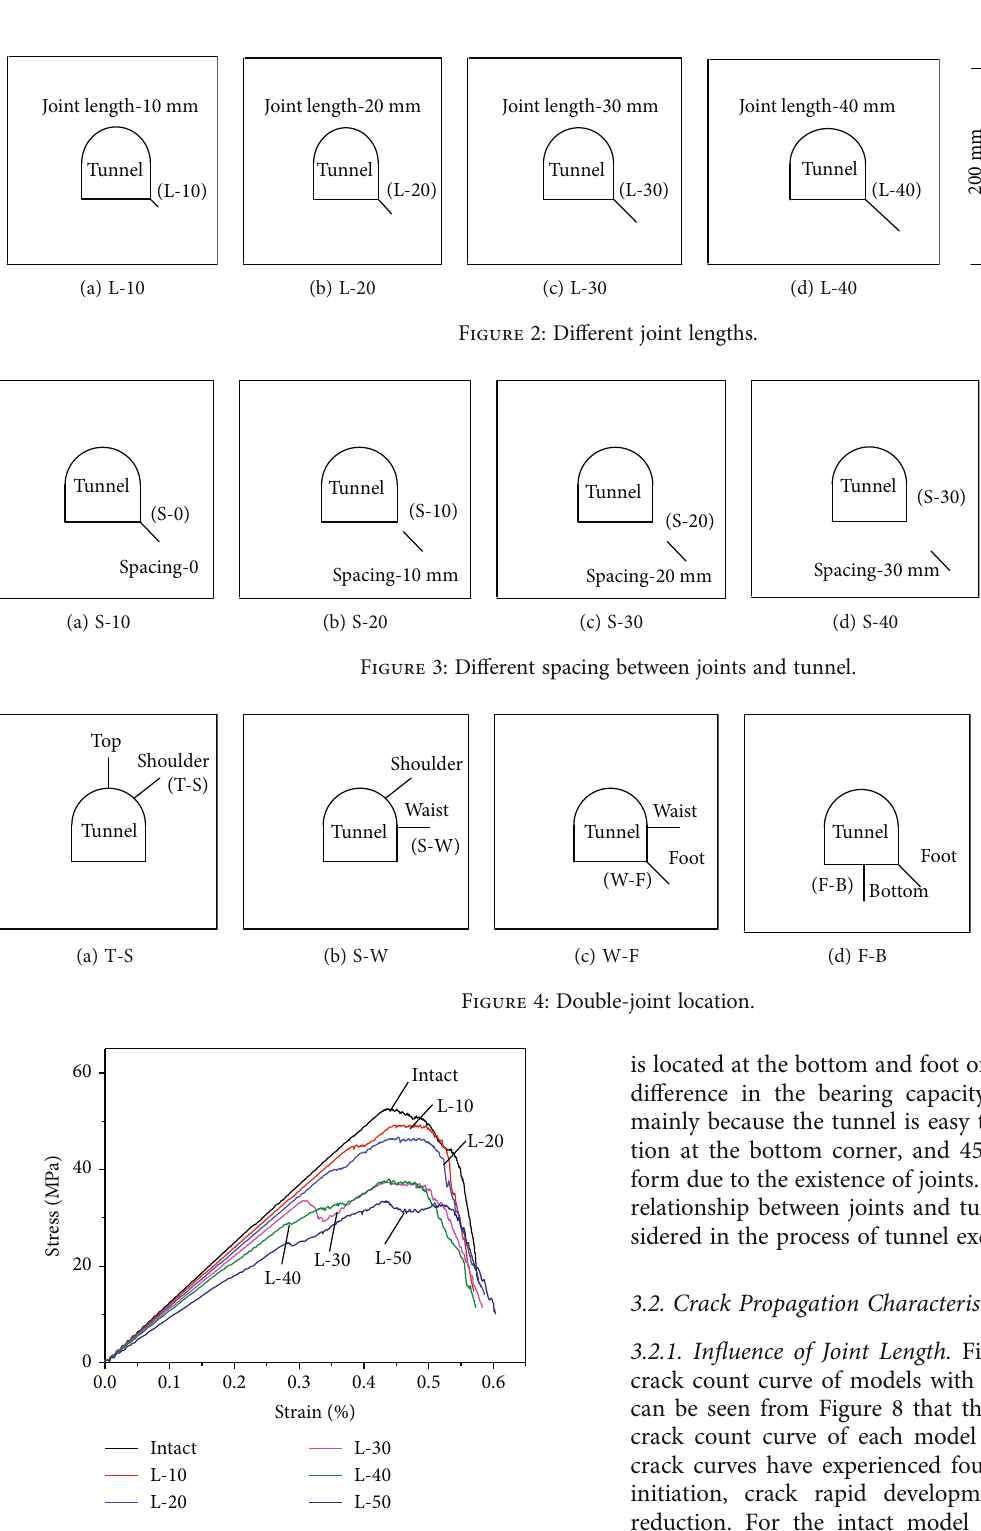
Figure 5: Stress-strain curves of models with di ff erent joint